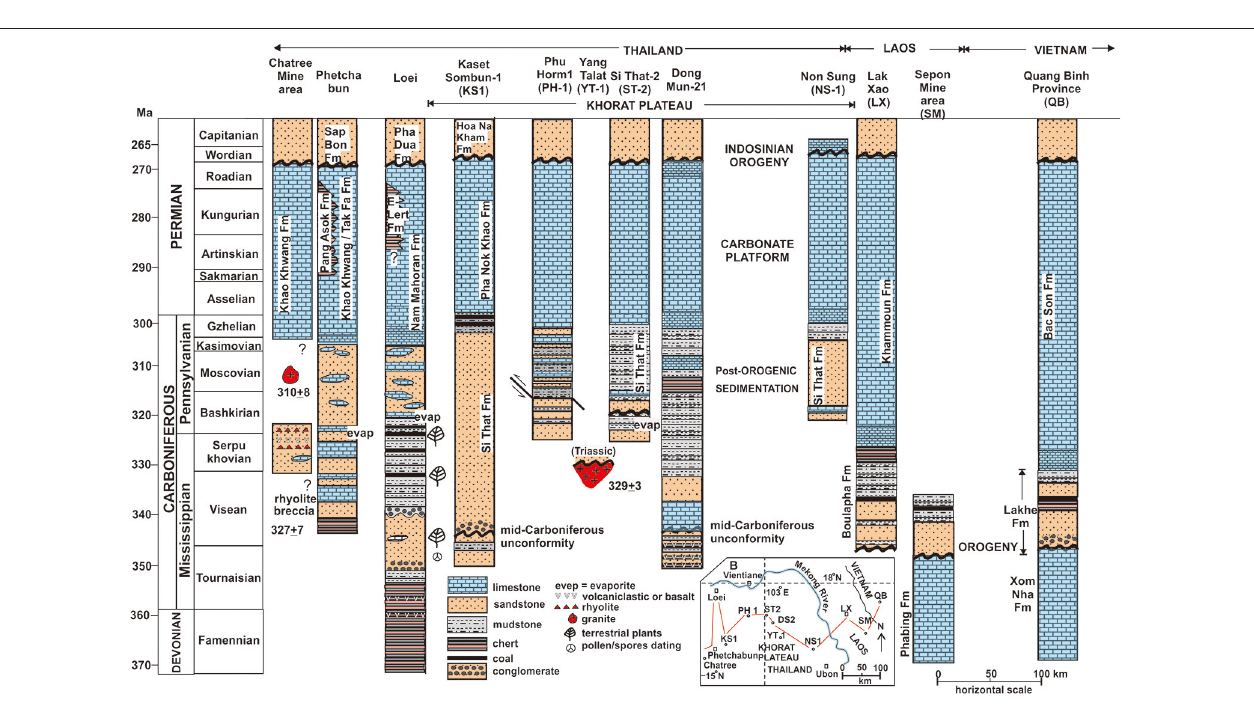
FIGURE 4 | Diagram showing stratigraphic successions from Famennian (Late Devonian) to mid-Permian across the Indochina region based on numerous authors. Line of section from Phetchabun Province and Loei Province of Thailand across the subsurface of the Khorat Plateau to Laos and Vietnam is shown in inset